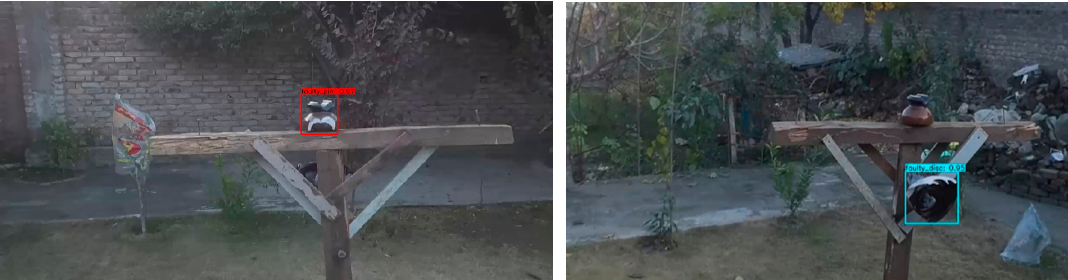
Figure A5. Test results of the proposed YoloV4-based faulty insulator detection model with flight path patterns.